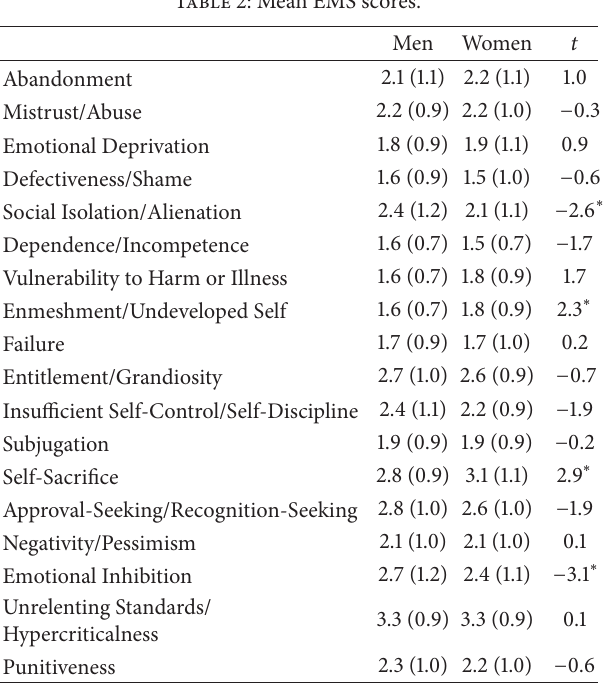
Table 2: Mean EMS